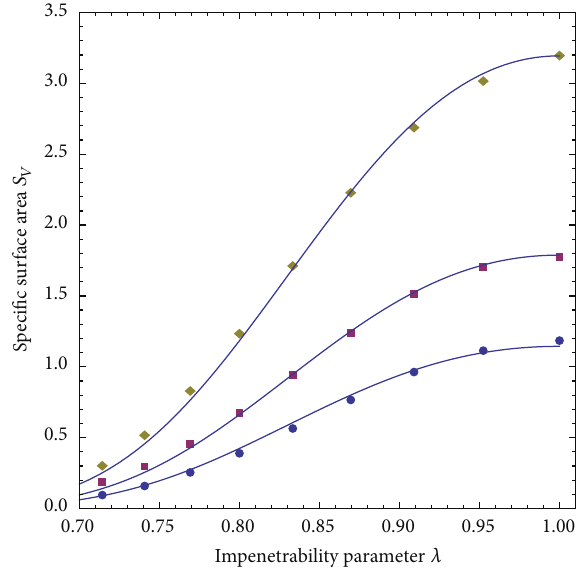
Figure 7: Specific surface area of cherry-pit models for Gamma distributed pore size with 𝜎/𝑟 = 0.25 (rhombs), 0.71 (squares), and 1.00